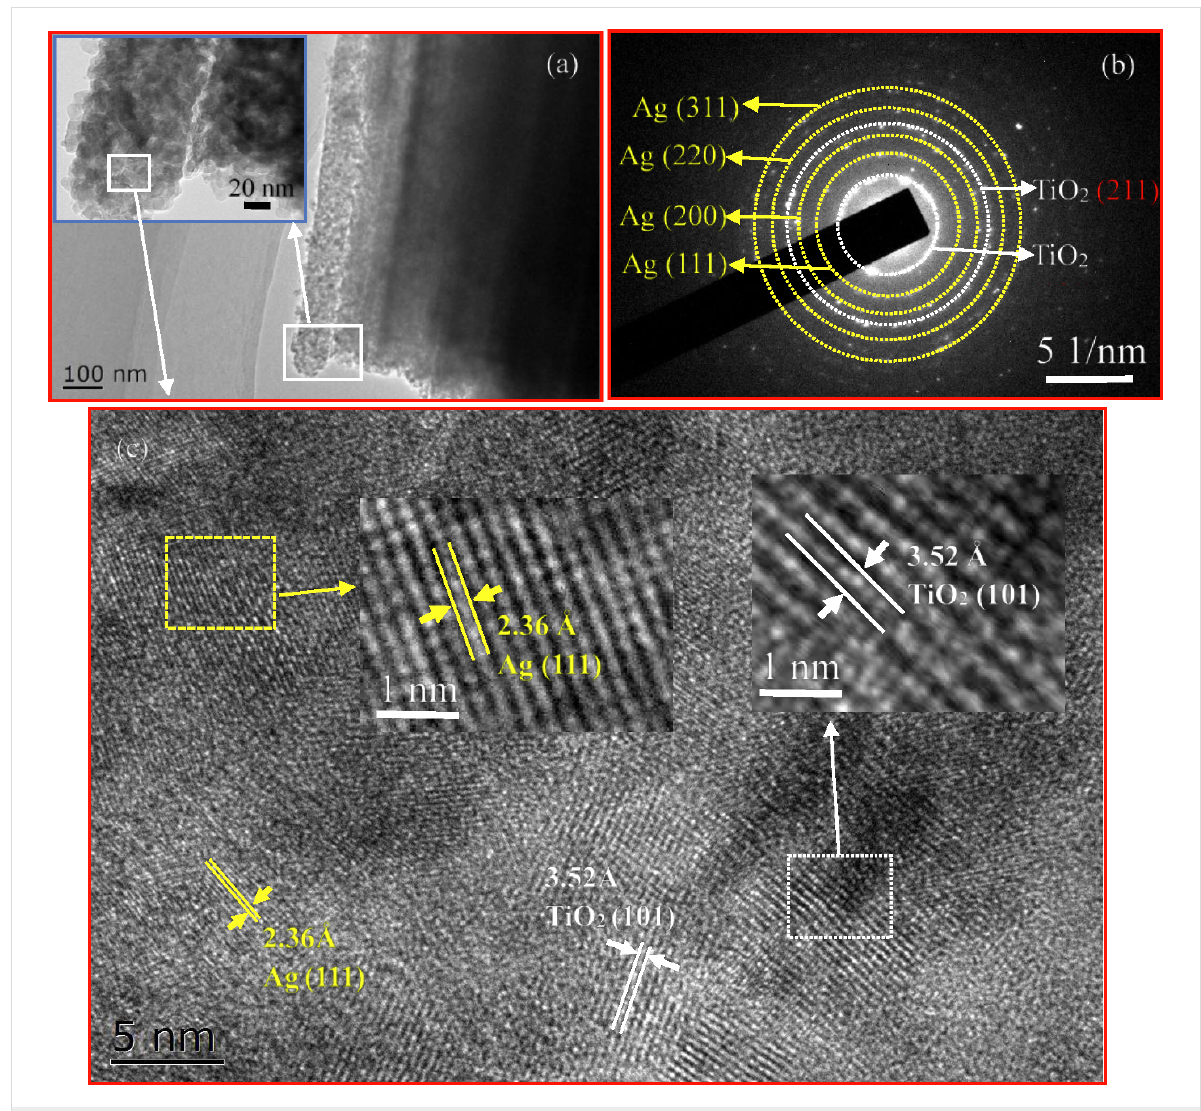
Figure 7: TEM images of the TiO 2 nanotube arrays with Ag nanofilm heat treated at 500 °C for 2 h; (a) TEM image of a TiO 2 nanotube covered by a Ag nanofilm, which consists of numerous Ag nanoparticles, (b) SAED pattern showing the presence of Ag nanocrystals, and (c) HRTEM image of the Ag nanofilm showing characteristic lattice spacings of 3.52 Å for TiO 2 nanotubes and 2.36 Å for